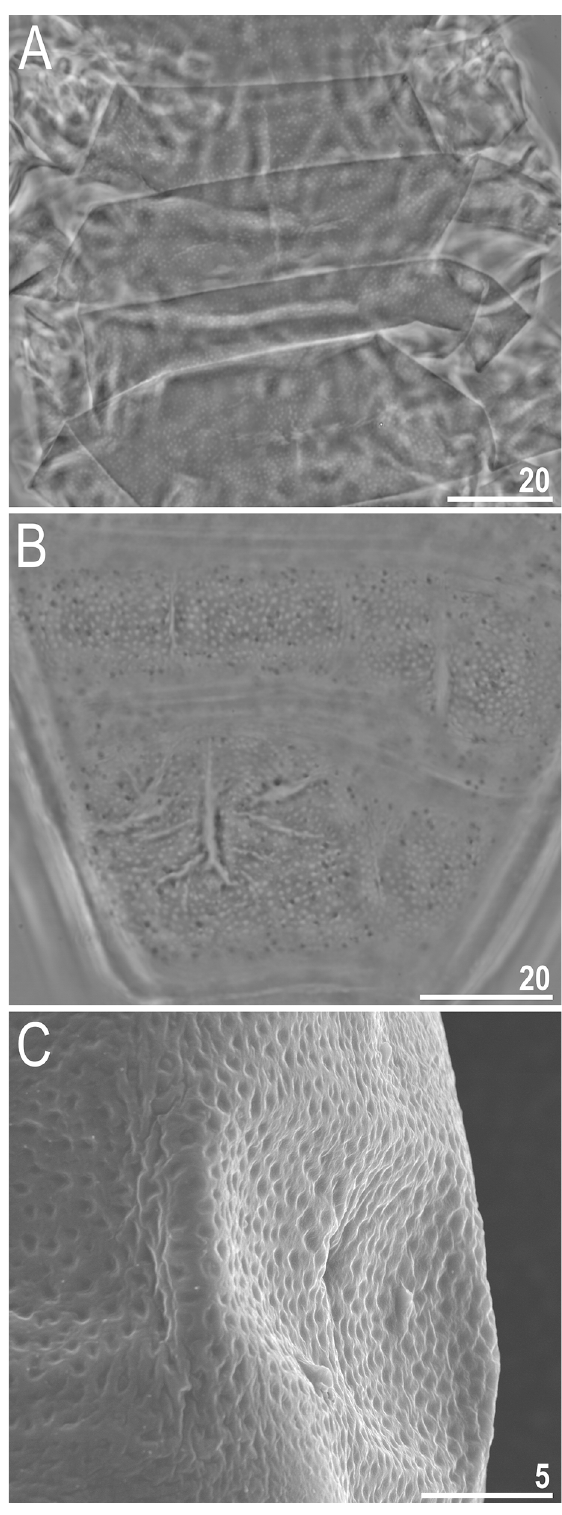
Figure 7. Cuticle morphology of the Milnesium granulatum morphogroup. ( A ) dorsal cuticle of M. reticulatum , PCM; in the microphotograph the reticulation is clearly visible but the gibbosities are absent; ( B ) dorsal cuticle of M. krzysztofi , PCM; ( C ) dorsolateral cuticle of M. krzysztofi , SEM. All scale bars in